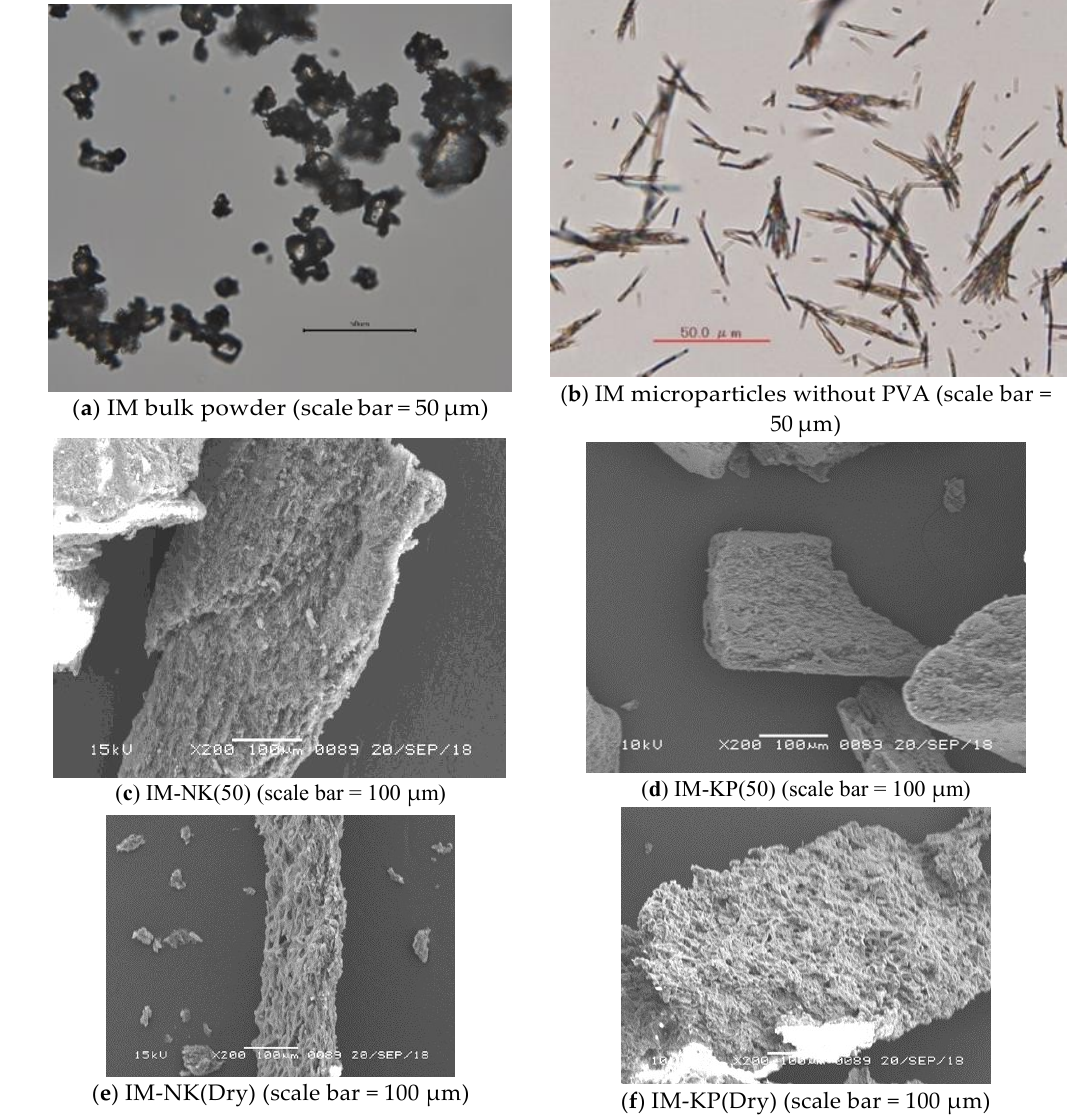
Figure 4. ( a , b ) Optical Micrographs of IM Bulk Powder and IM Microparticles Without PVA; ( c – f ) Scanning Electron Microscopy Images of IM-NK(50), IM-KP(50), IM-NK(Dry), and IM-KP(Dry).